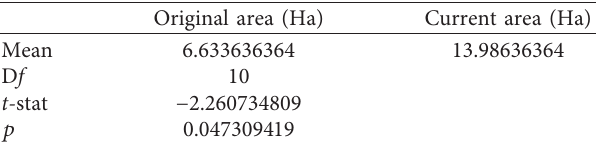
Table 3: Comparative analysis of check survey of some selected farms ( n � 11) in three forest